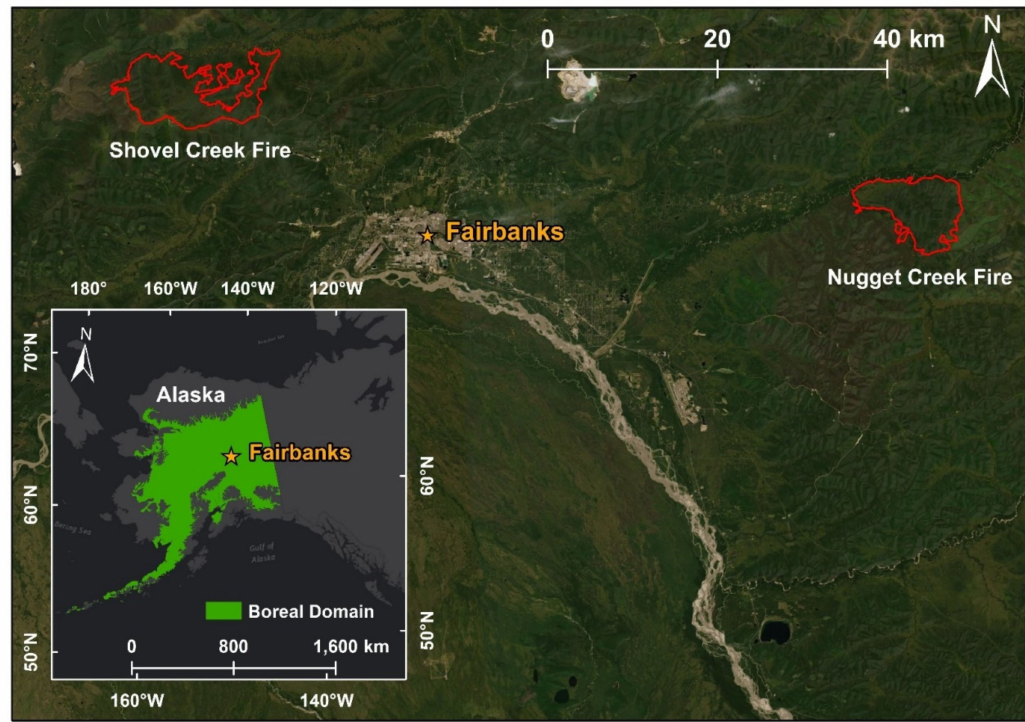
Figure 1. Location of 2019 Shovel Creek fire and Nugget Creek fire burn scars in relationship to the Alaskan Boreal Forest and